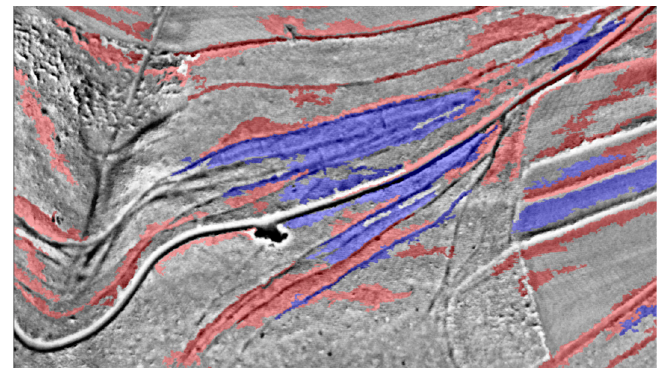
Figure 16 . Misclassifications in a hillside situation in Höxter in a DM [13]. Figure 16. Misclassifications in a hillside situation in Höxter in a DM [13].